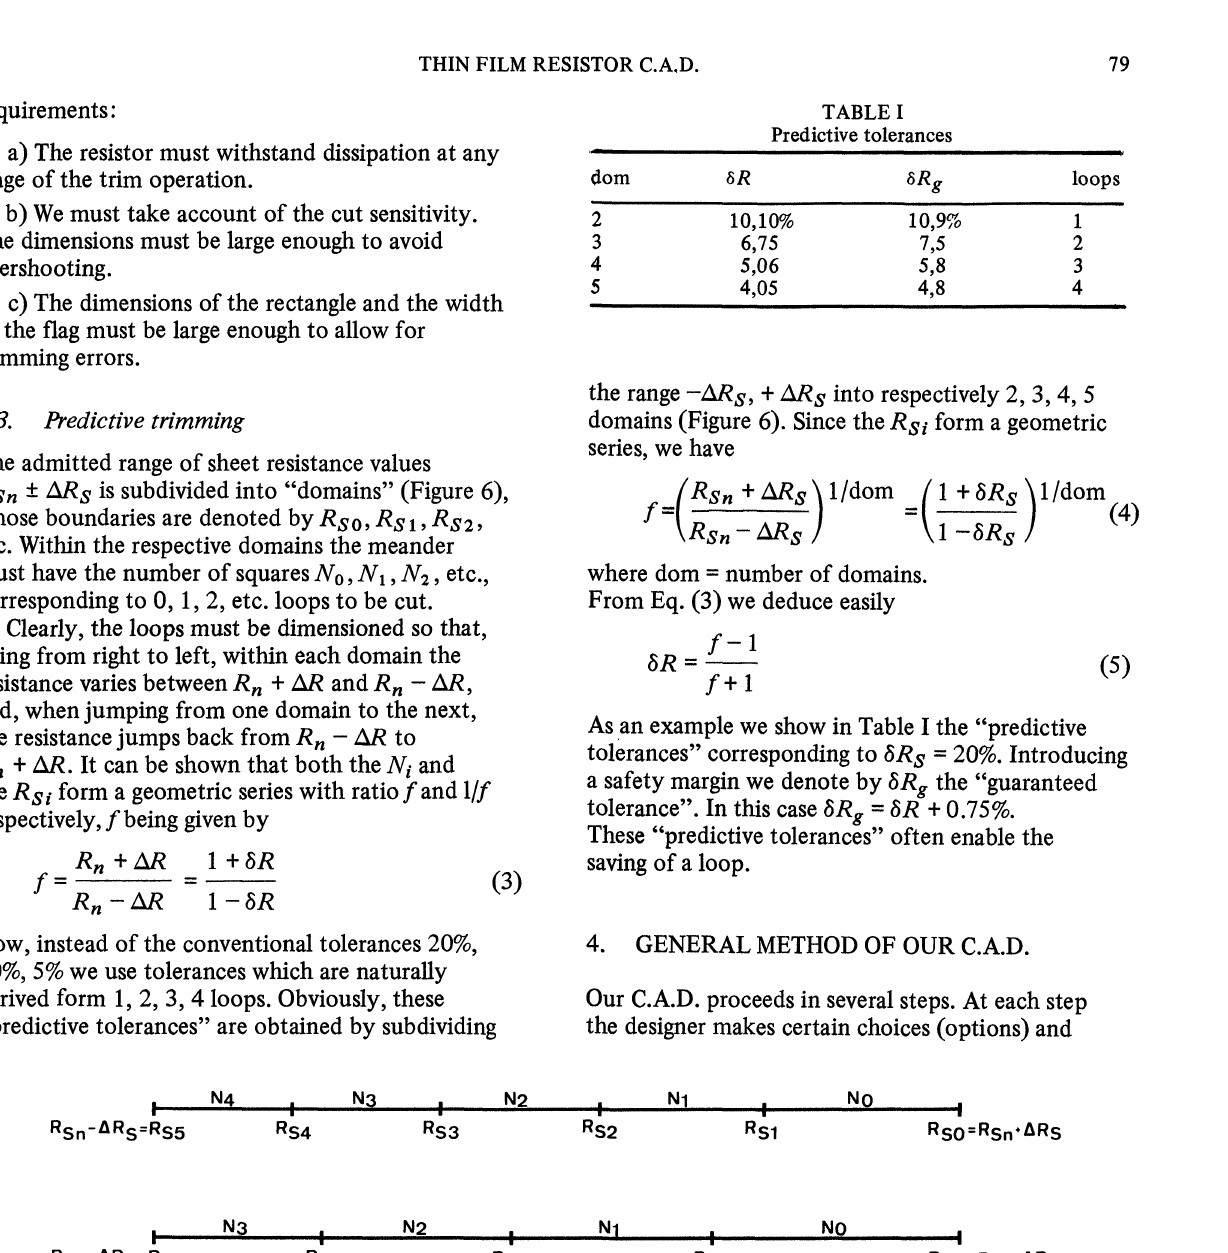
TABLE Predictive tolerances 8Rg